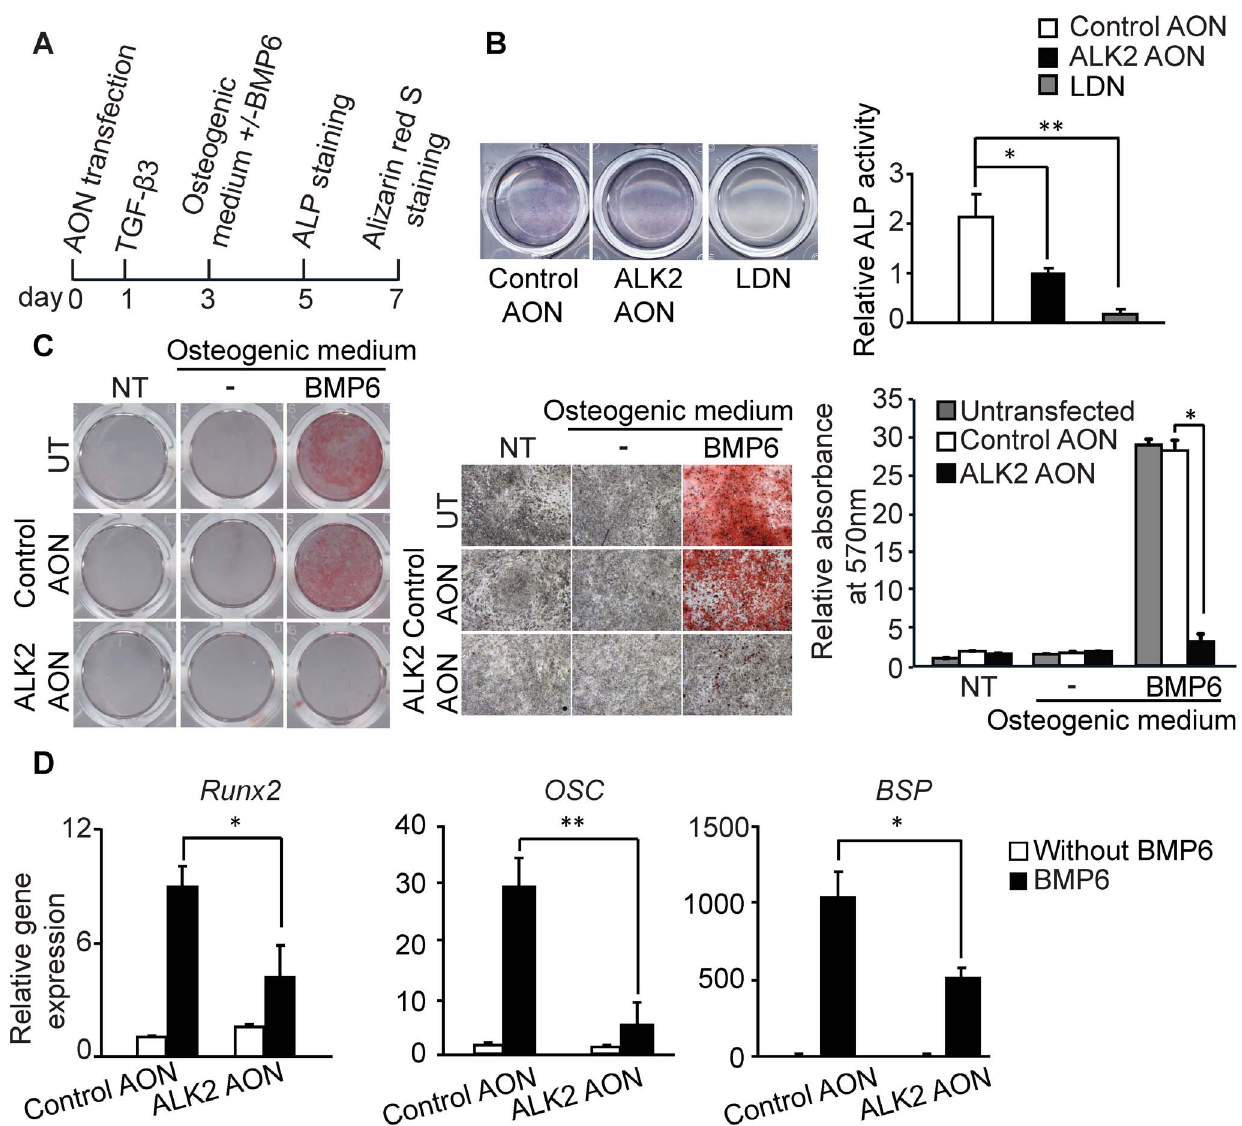
Figure 5. BMP-induced osteoblast differentiation was impaired by ALK2 AON-induced exon skipping in MEECs. (A)As a mineralization assay, MEECs were seeded into a 24-wells or 48-wells plate. One day after transfection, cells were stimulated with 5 ng/ml TGF- b 3 for 2 days and switched to osteogenic medium with or without 100 ng/ml BMP6 for several days (with medium refreshment after 4 days). ALP staining was performed 2 days after maintaining in osteogenic medium. After 4 days in osteogenic medium, the cells were fixed and stained with 2% alizarin red S solution for mineralization staining. (B) MEECs were transfected with 200 nM control AON or 200 nM ALK2 AON, and stimulated with osteogenic medium indicated in figure 4A. The LDN sample indicates LDN-193189 was present during the whole experiment. Representative microscopic pictures of staining (upper panel) are shown; ALP activity was represented as the average of three independent samples, and was normalized by protein concentration. (C) MEECs were transfected with 100 nM control AON or 100 nM ALK2 AON in grow medium and treated as in panel 4A. The mineralization was visualized by alizarin red S staining. The plate was scanned (4C, left panel), and scanned under a microscope (4x, 4C, middle panel). Alizarin red S staining was quantified by stain extraction and absorbance reading at 570 nm (4C, right panel). (D) RNA was collected in experiment 4C. mRNA expression of Runx2 , OSC and BSP was measured by qPCR. All the experiments were performed for three times and were normalized to Gapdh . Each value is the means 6 SD. Statistical analysis was performed using Student’s t-test, using the untransfected samples as reference. *P , 0.05, **P , 0.005.